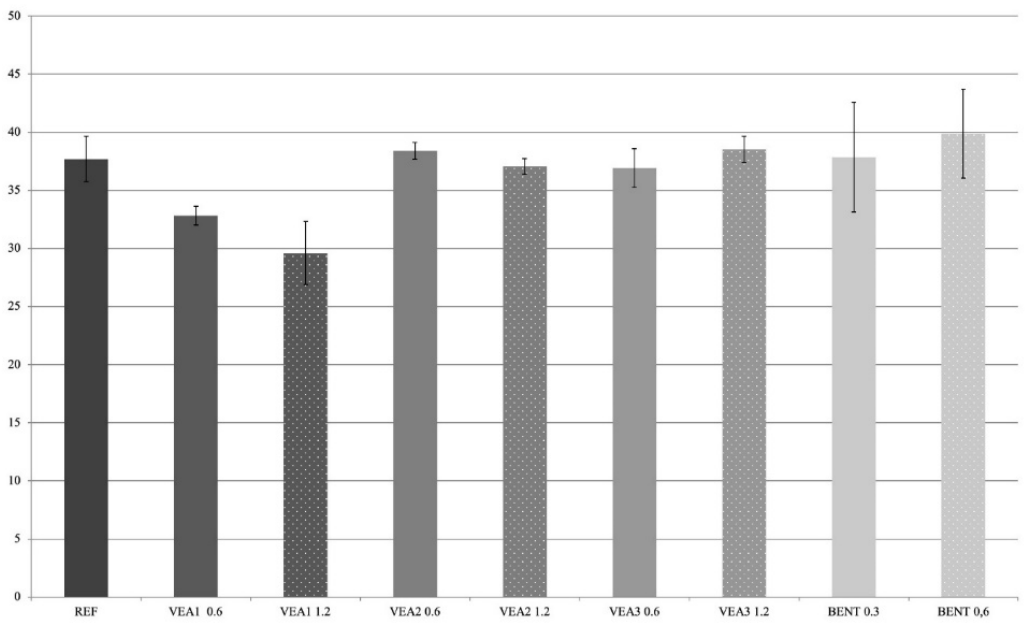
Figure 7. Compressive strength of all mixtures at age of 28